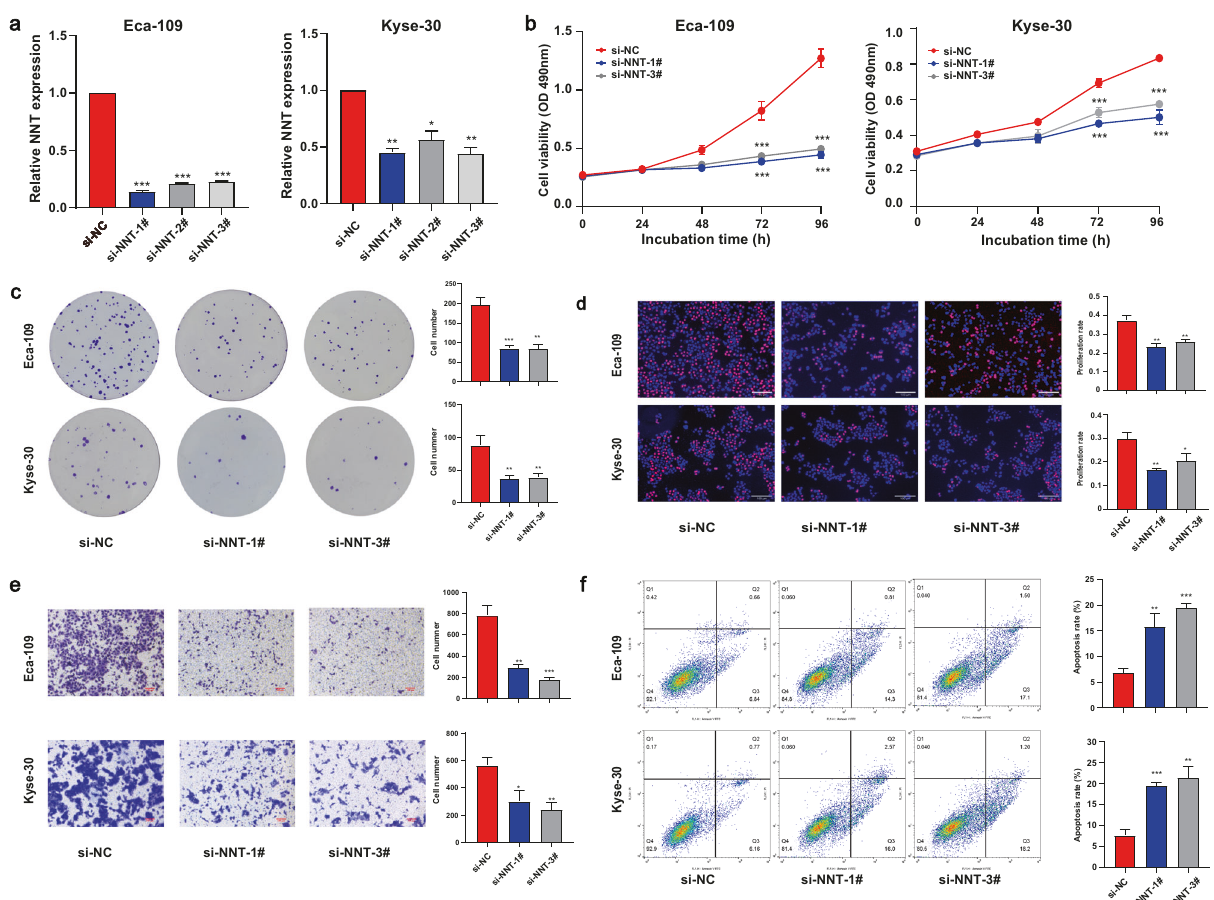
Fig. 4 Knockdown of NNT suppressed ESCC cell proliferation and migration. a The knockdown ef fi ciency of short interfering RNAs for NNT was measured in Eca-109 and Kyse-30; b – d Knockdown of NNT inhibited proliferation of Eca-109 and Kyse-30 cells using MTT assays, colony forming assays, and EdU assays; e knockdown of NNT inhibited the migration of Eca-109 and Kyse-30 cells; f Knockdown of NNT increased the apoptotic rate of both ESCC cell lines. The results were from three independent experiments. Data were analyzed by unpaired Student ’ s t -test. *** P < 0.001, ** P < 0.01, * P < 0.05. Variables were presented as the Mean ± SD.